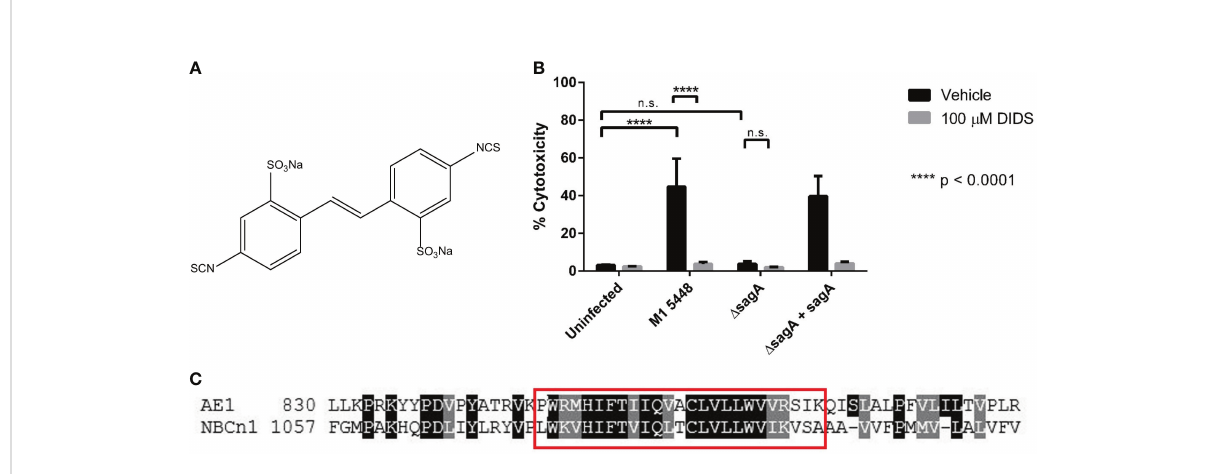
FIGURE 1 SLS-mediated keratinocyte cytotoxicity involves proteins that are associated with ion transport. (A) Chemical structure of the stilbene disulfonate DIDS. (B) Keratinocytes were pretreated for 1 hour with 100 µM DIDS, and then were infected with GAS at MOI 10 for 6 hours. Percent cytotoxicity was determined post-infection using an ethidium homodimer assay. DMSO was used as a vehicle control for all infections. Data are presented as mean ± sd, with n = 3 for each condition. (C) Band 3 and NBCn1 have a similar region near their C-termini. A protein BLAST was used to identify proteins with similar sequences to the synthetic peptide used by Higashi et al. to inhibit SLS-dependent hemolysis (Higashi et al., 2016). NBCn1 was found to exhibit a high degree of similarity in the region spanned by this peptide. A selection of the alignment between Band 3 (AE1) from Ovis aries (NCBI Reference Sequence XP_004013030.3) and human NBCn1 (GenBank ACH61959.1) is shown. The red box denotes the AE1 sequence used to generate the synthetic peptide used as a query. **** = P < 0.0001, n.s. = not signi fi